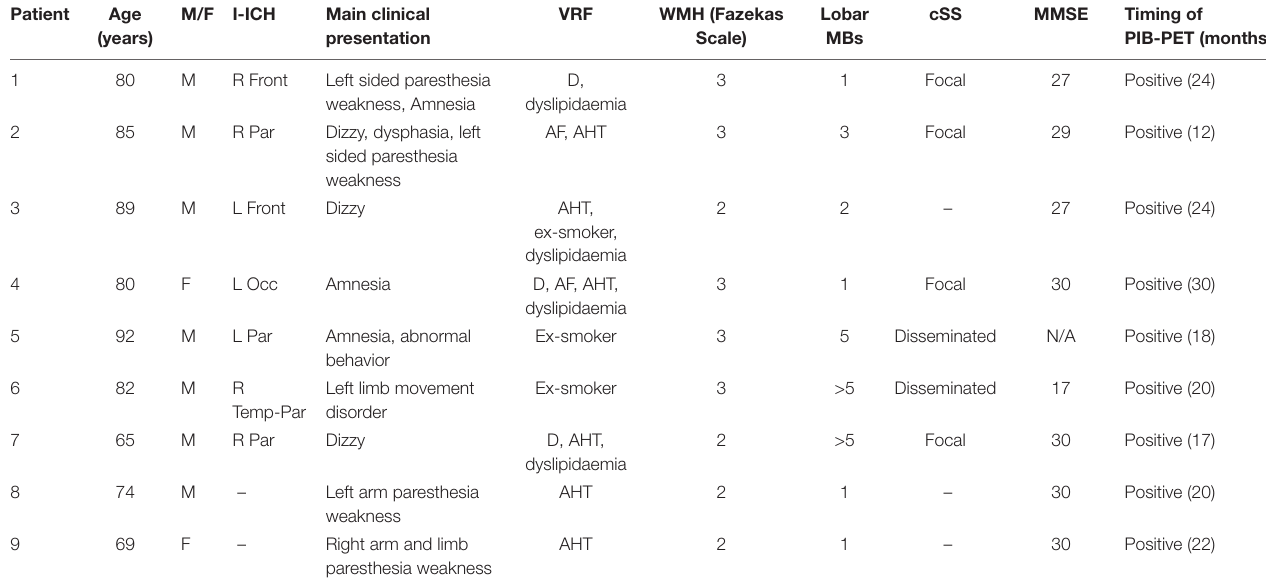
TABLE 1 | The demographics and clinical characteristics of patients with cerebral amyloid angiopathy (CAA).